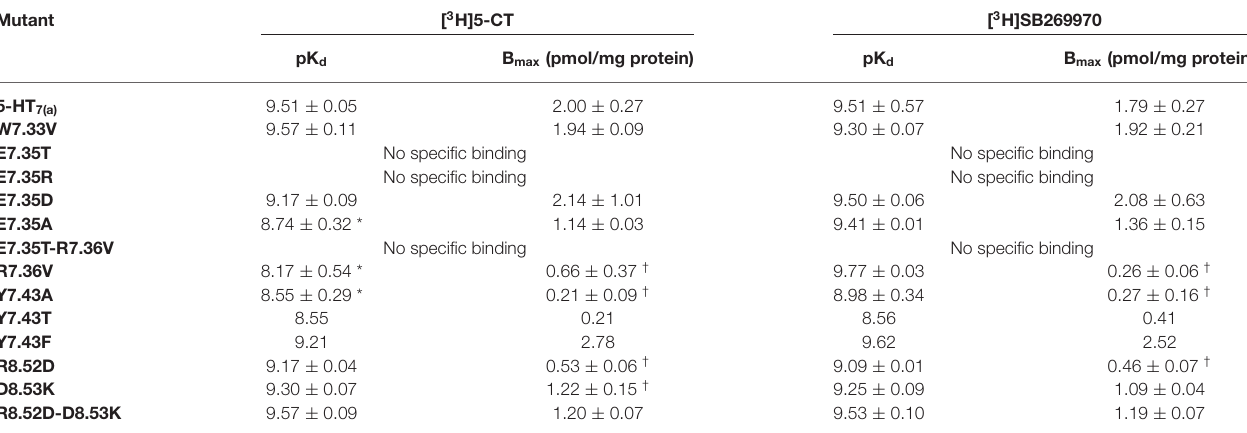
TABLE 4 | Binding properties of wild-type and mutant 5-HT 7(a) receptors expressed in QBI-HEK293 cells . Mutant